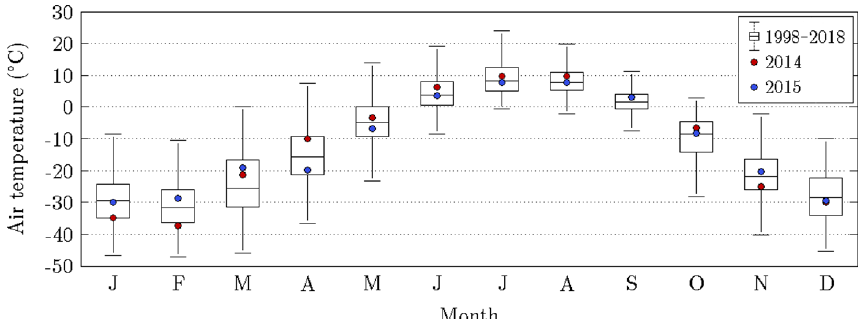
Figure 4. Annual course of air temperature on Samoylov Island for the years 2014 and 2015, as well as the recent 20-year baseline (Boike et al., 2013, 2019). In each box plot, the central mark denotes the monthly median, and the bottom and top edges indicate the 25th and 75th percentiles, respectively. The whiskers extend to the most extreme data points excluding outliers. During the warm season, when flux data were available (June to September), 2014 was mostly warmer than